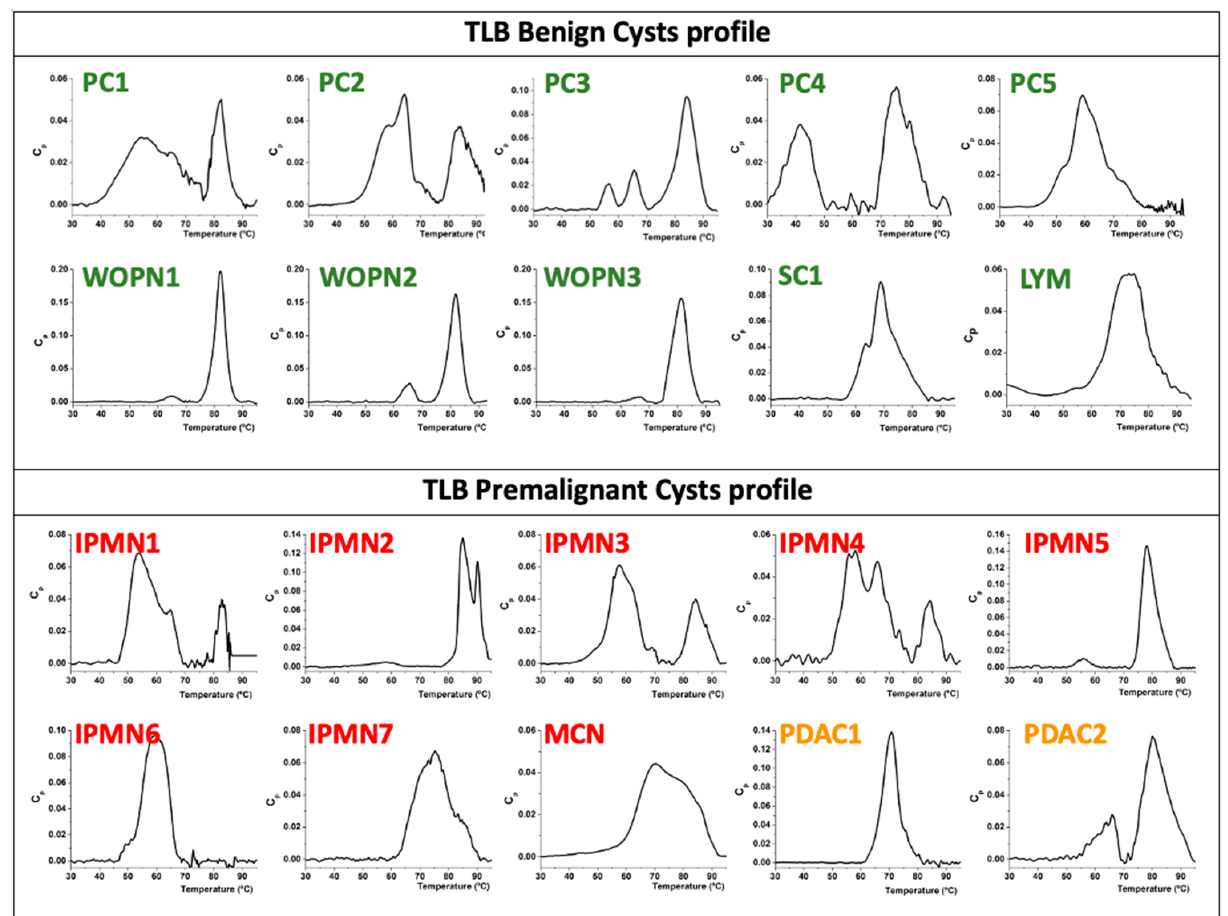
Figure 1. Individual TLB thermograms from cystic liquid samples. Samples were clustered according to their benign or premalignant nature.